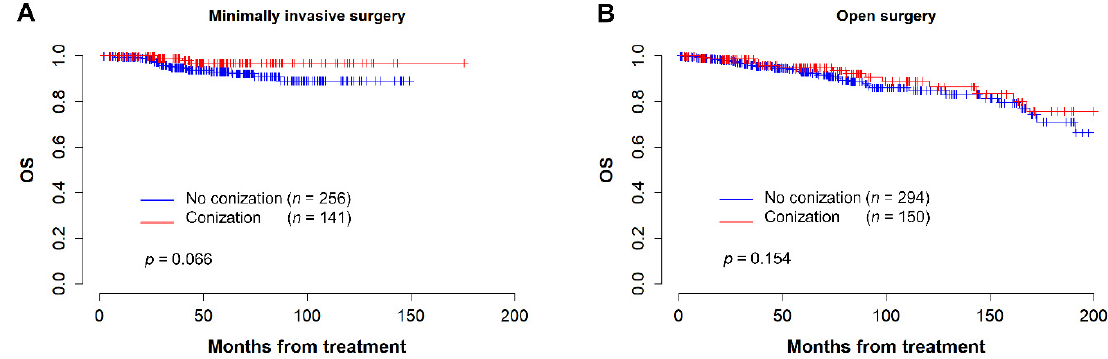
Figure 4. Kaplan–Meier curves for overall survival in subgroup analysis. ( A ) Patients who under ‐ went minimally invasive surgery; ( B ) Patients who underwent open surgery; ( C ) Patient without pelvic lymph node metastasis; ( D ) Patients with pelvic lymph node metastasis; ( E ) Patients with tumor size less than 4 cm; ( F ) Patients with tumor size over 4 cm. Furthermore, we grouped the patients according to the total tumor size. In patients with tumor size less than 4 cm, the conization group showed similar PFS ( p = 0.163) but superior OS ( p = 0.042) than the control group (Figures 3E and 4E). However, there was no difference in survival for preoperative conization in patients with tumors larger than 4 cm (Figures 3F and 4F). The trend of a superior OS with conization persisted even when we further split the patients with tumor size less than 4 cm into groups with tumor size < 2 cm and those with tumor size ≥ 2 cm and < 4 cm, but statistical significance was lost (Supplementary Figure S1). In our matched cohort, 86.3% (251/291) of the conization group had a positive re ‐ section margin of conization. Among the three subgroups according to tumor size (<2 cm, ≥ 2 cm and <4 cm, and ≥ 4 cm), patients with larger tumor size were more likely to show positive resection margin of conization (81.6% (80/98) vs. 87.3% (103/118) vs. 91.9% (68/75), p = 0.049). However, no significant difference in survival was observed between